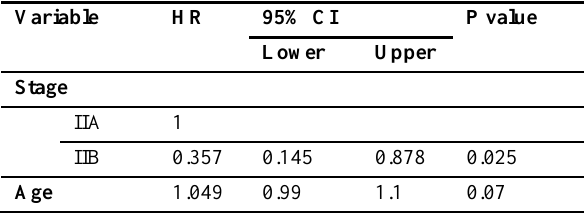
Table 2: Multivariate analysis for overall